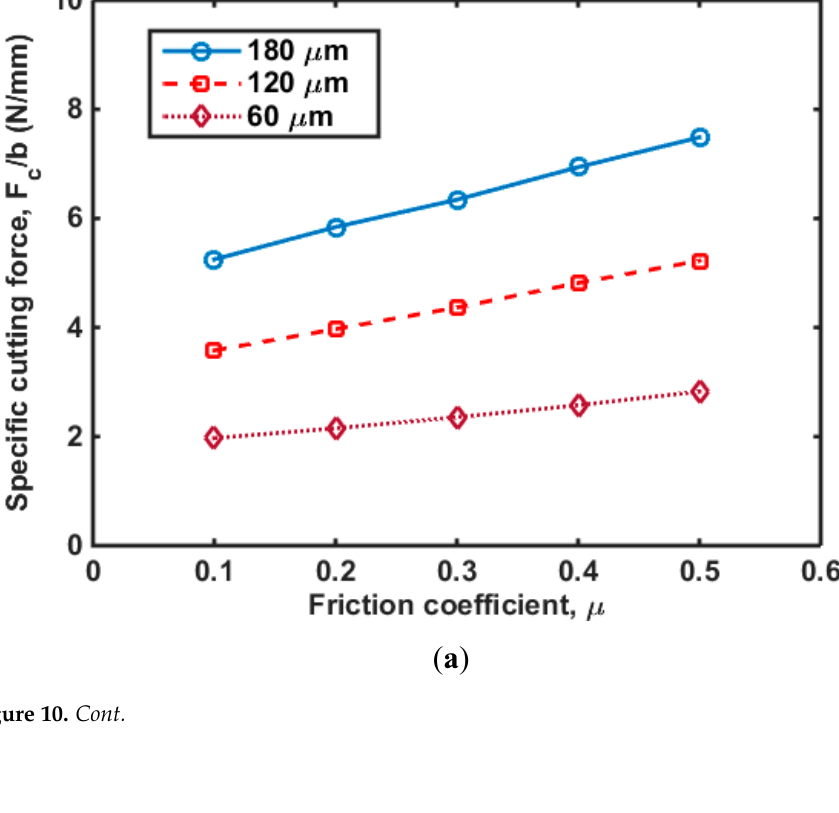
( b ) Figure 10. Cutting force in ( a ) cutting direction and ( b ) transverse direction as a function of friction coefficient in HDPE with a rake angle of 30°.